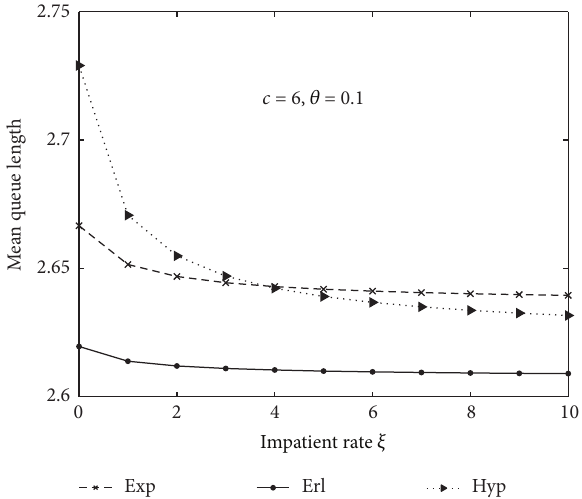
Figure 10: Mean queue length versus impatient rate with 𝜌 = 0.1 , = 0.5 , and 𝑐 = 1 . 𝜇 V